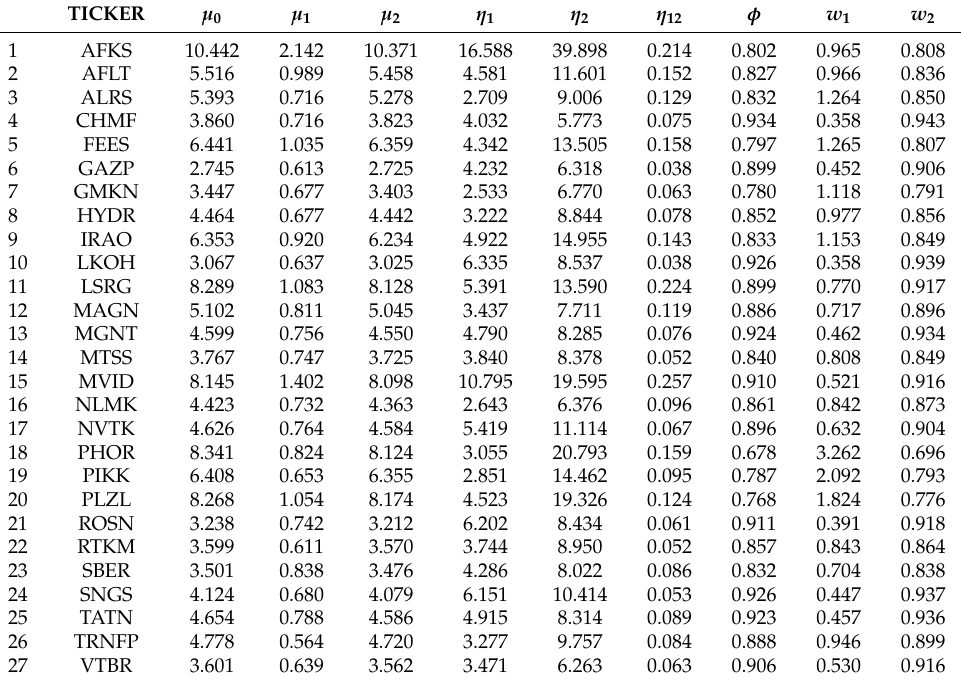
Table A3. Optimal measure of daily volatility: Empirical estimates of